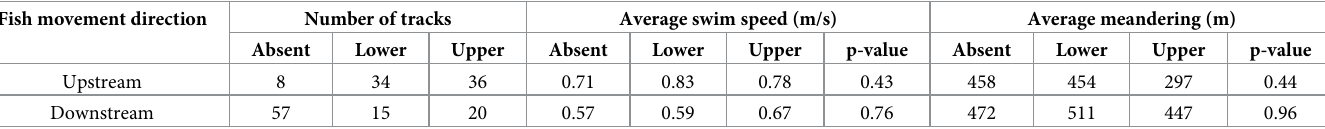
Table 1. Results of permutation tests comparing swim speed and meandering behavior factoring in swim direction and dredge location. Fish movement direction Number of tracks Average swim speed (m/s) Average meandering (m) Absent Lower Upper Absent p-value Upstream 8